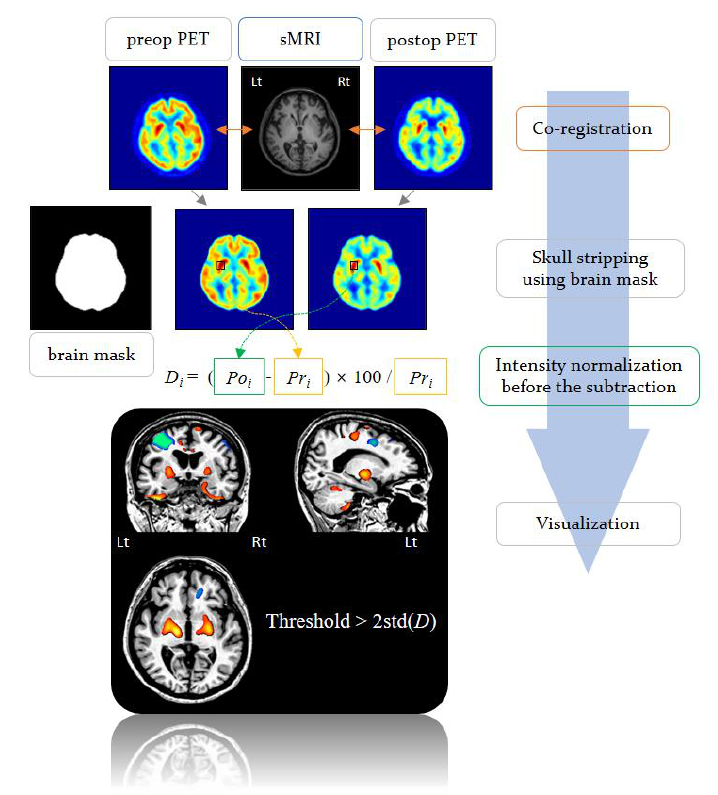
Figure 4. The process of voxel-based subtraction analysis of positron emission tomography (PET) images. In the present study, the threshold was set at 2 standard deviations (SD) from the mean value.